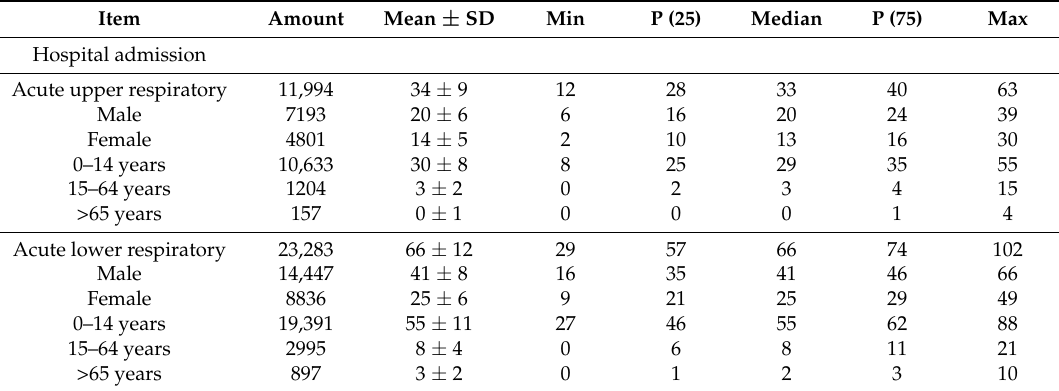
Table 1. Descriptive statistics of daily respiratory hospitalizations for Shenzhen (2013).